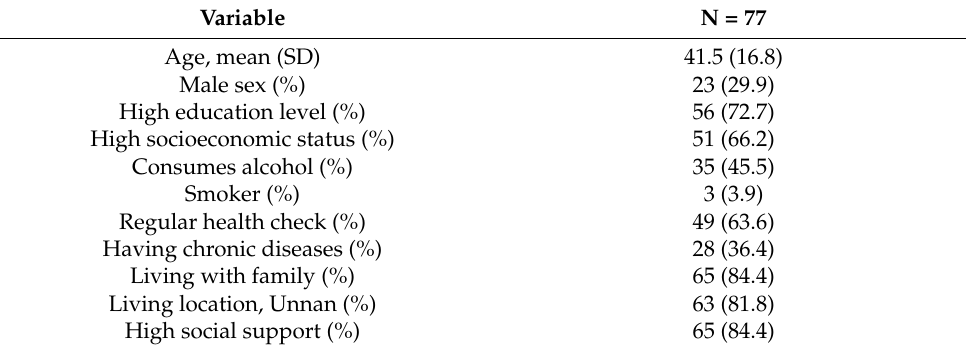
Table 1. Demographics of persons who participated in the Osekkai